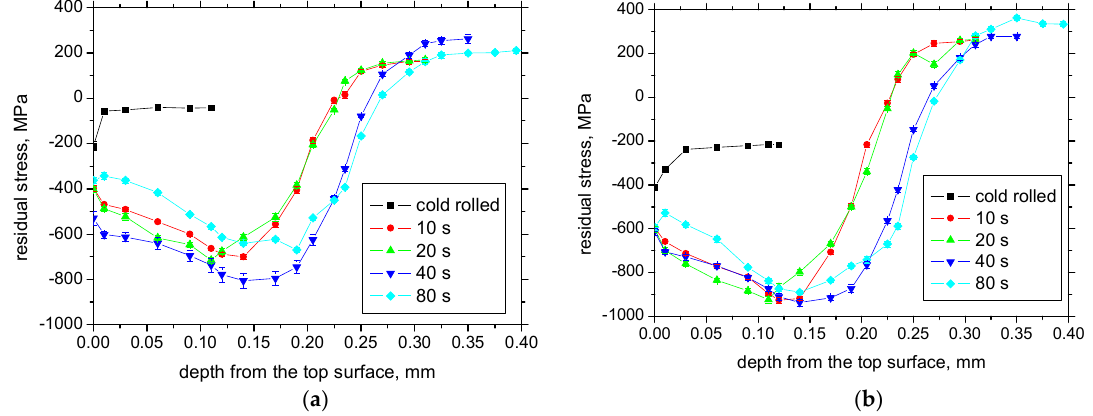
Figure 5. Stress profiles for the rolling direction (RD) and transversal direction (TD) directions. ( a ) RD direction, ( b ) TD direction.